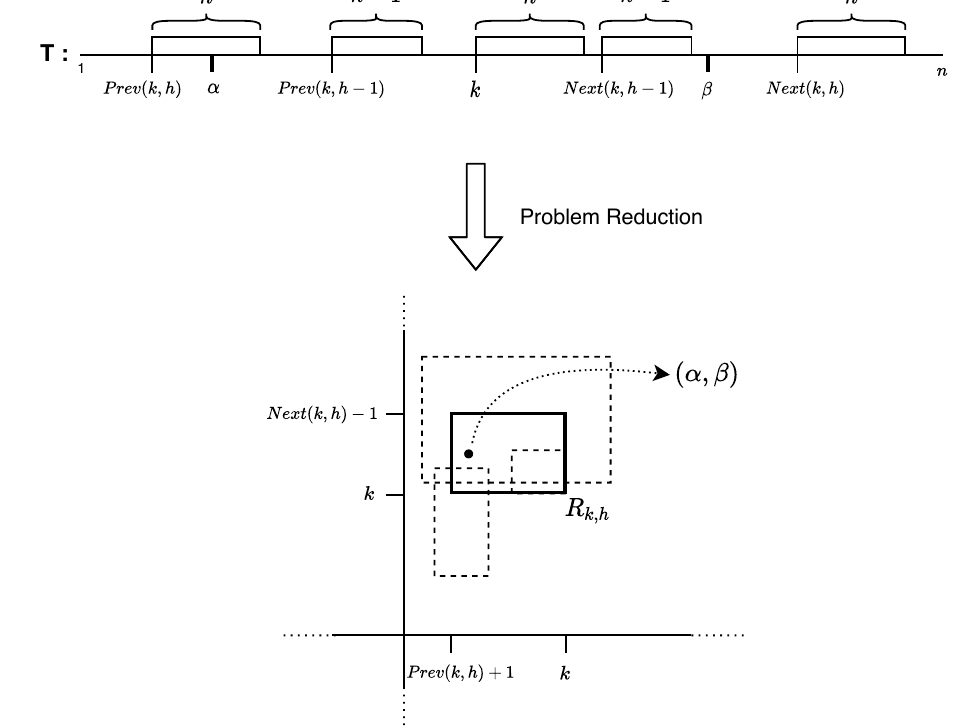
Figure 1. Illustration of the problem reduction: ( k , h ) is the output of the rSUS problem with query range [ α , β ] , where h = λ ( α , β , k ) ∈ C k . R k , h is the lowest weighted rectangle in R containing the point ( α , β )